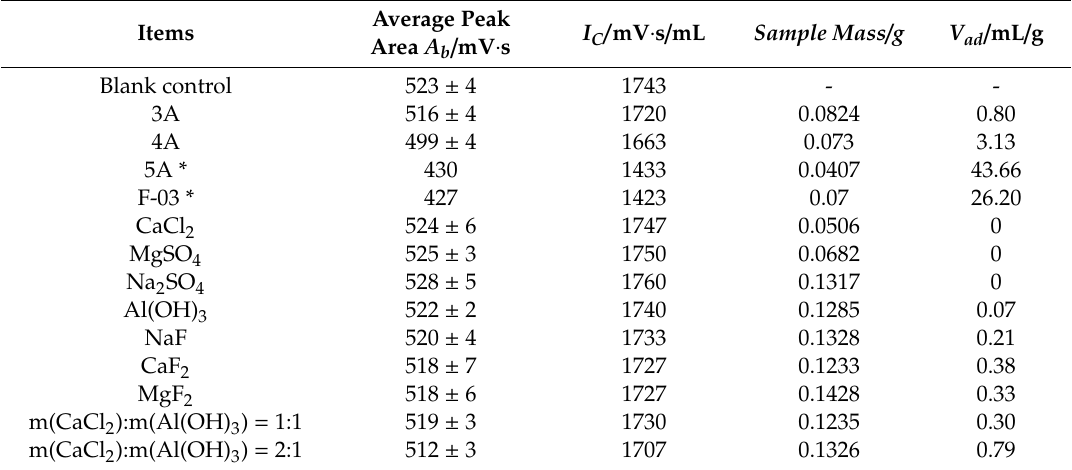
Figure 6. Adsorption performance of adsorbent materials with CO 2 tested with pulse adsorption, ( A ) Blank control, ( B ) 3A, ( C ) 4A, ( D ) 5A molecular sieve, ( E ) F-03.